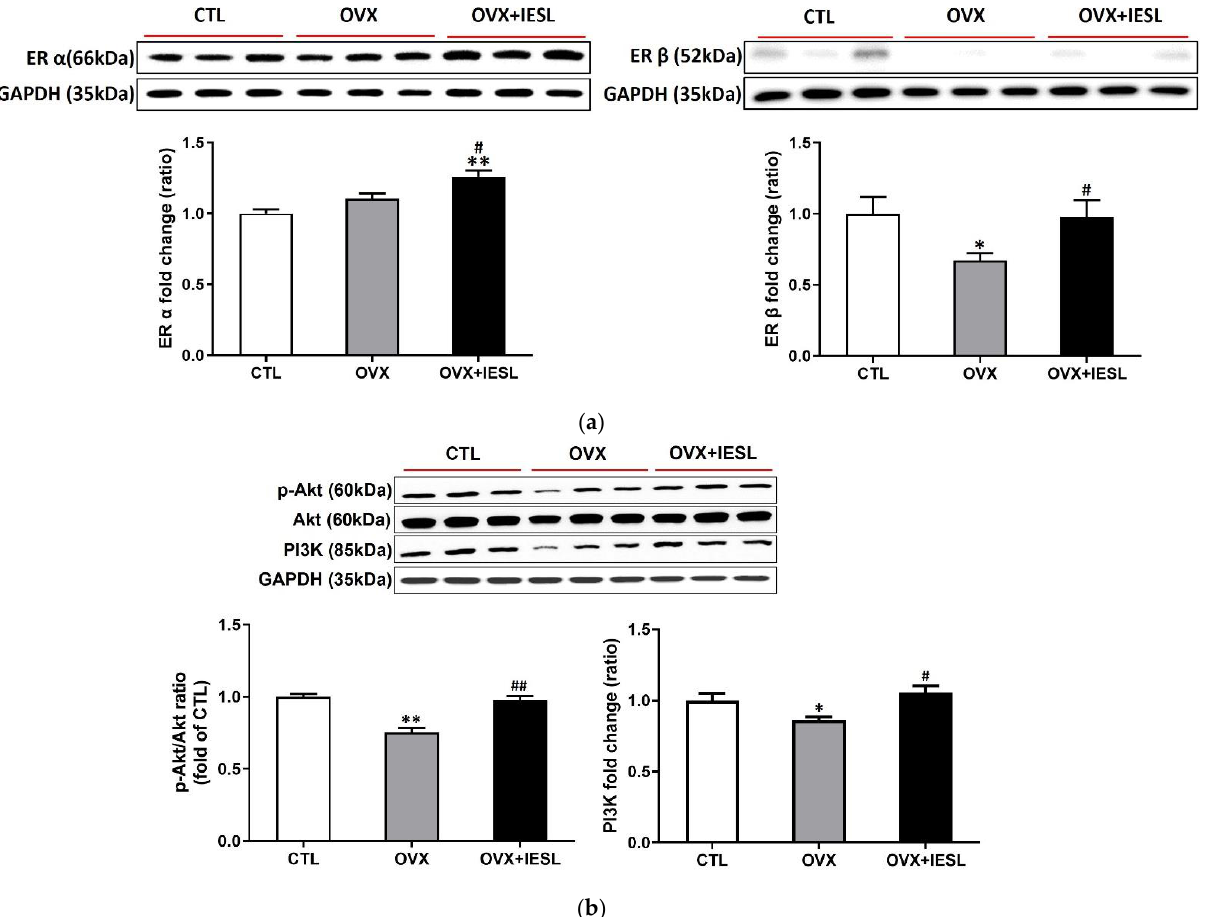
Figure 4 . Effects of the IESL extracts on the expression of ERs and the PI3K/Akt pathway. Ovariec- tomy did not induce a significant change in the expression of ER α but decreased the expression of ER β ( a ). In the OVX+IESL group, the administration of IESL significantly increased both ERs com- pared to the OVX group. In the OVX group, expression of the PI3K and p-Akt/Akt ratio are signifi- cantly decreased compared with the CTL group, but the treatment of IESL restored them in the OVX+IESL group ( b ). Data are expressed as the mean ± S.E.M. * p < 0.05 and ** p < 0.01 vs. the CTL group; # p < 0.05 and ## p < 0.01 vs. the OVX group.